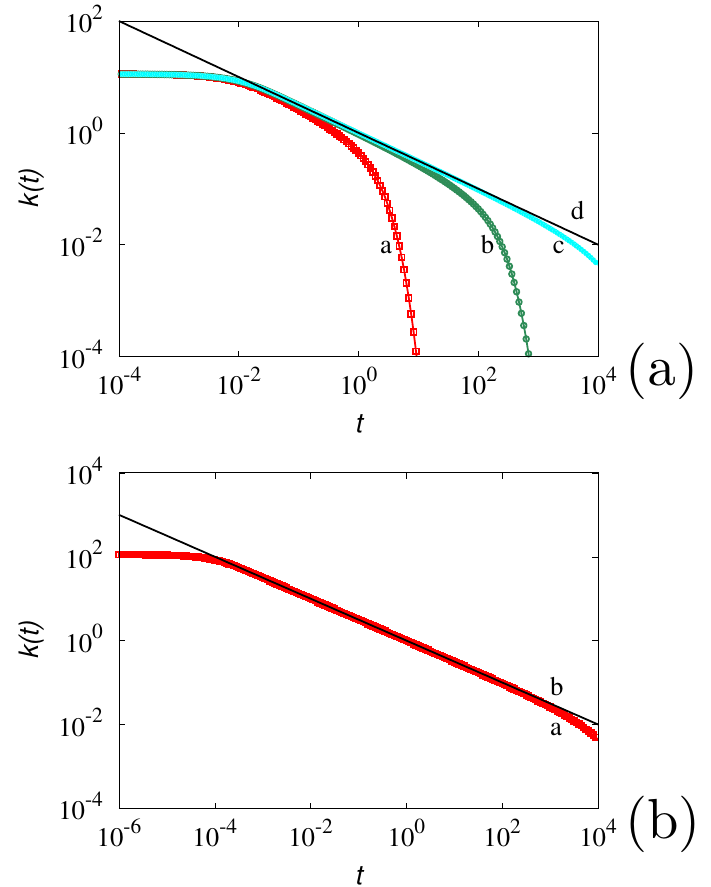
Figure 1. Behavior of the discretized k k ( t ) defined by Equation (34) for different discretizations. Panel ( a ) refers to k max = 10, lines and symbols (a) to (c) correspond to ∆ k = 1, 0.1, 0.01, respectively. Line √ t . Panel ( b ) k max = 100, ∆ k = 0.01 (line a), while line (b) depicts k ∞ ( t ) (d) represents k ∞ ( t ) = 1/